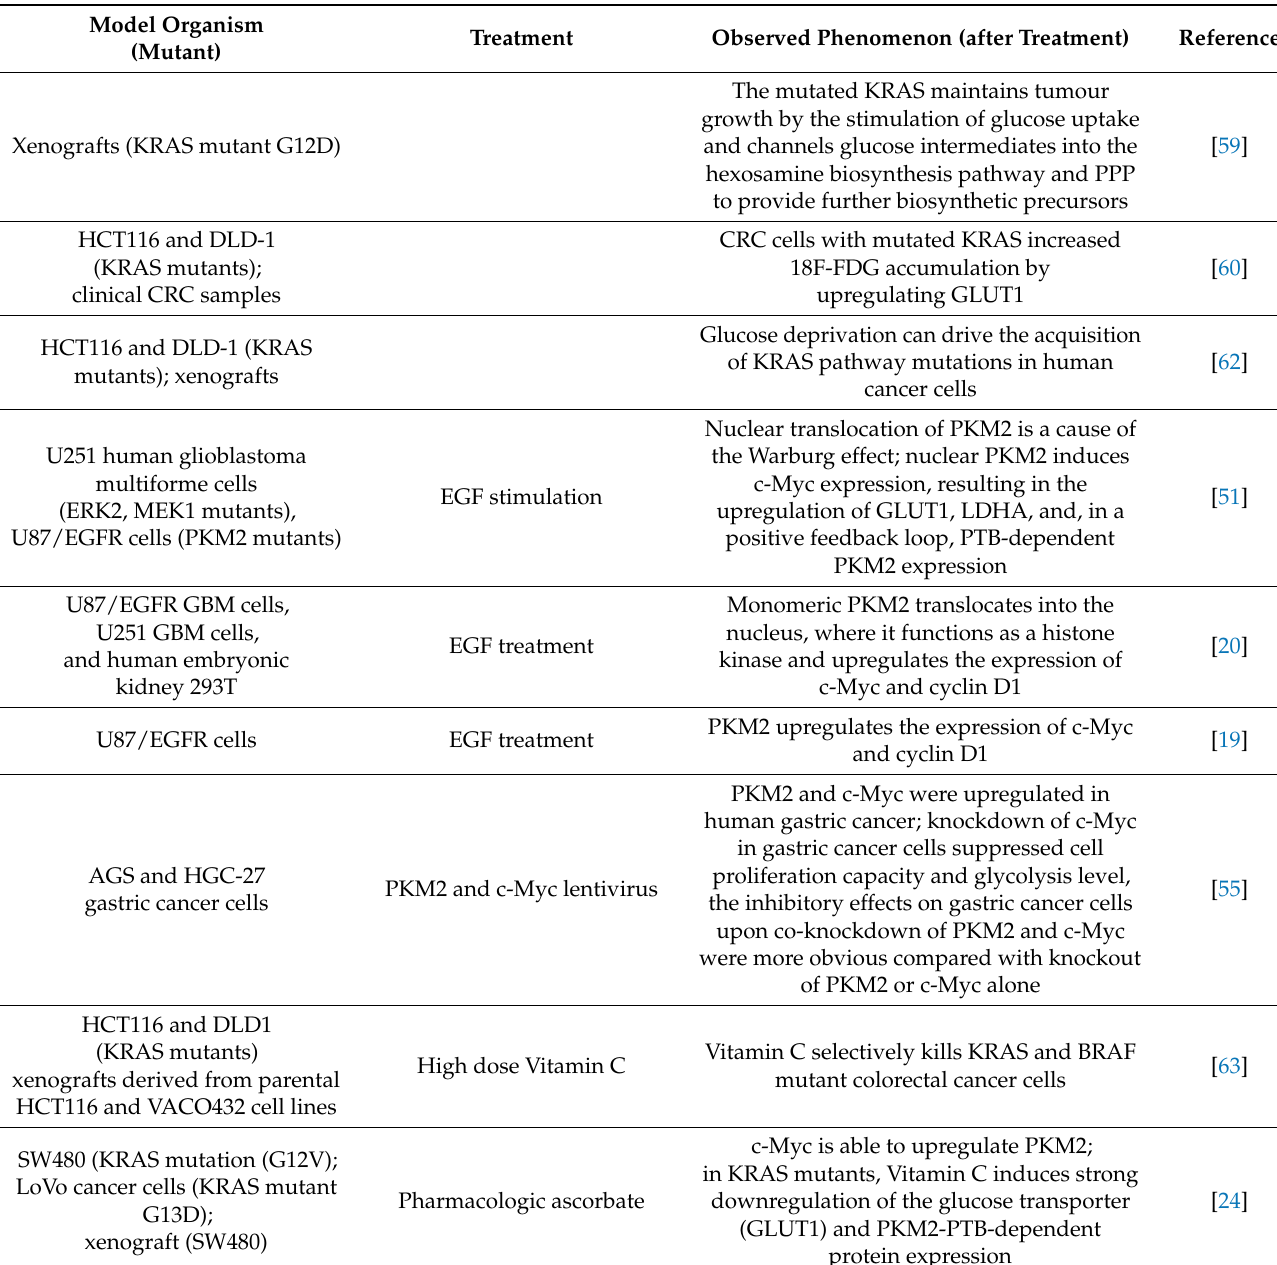
Table 1. Experimental observations underlying our